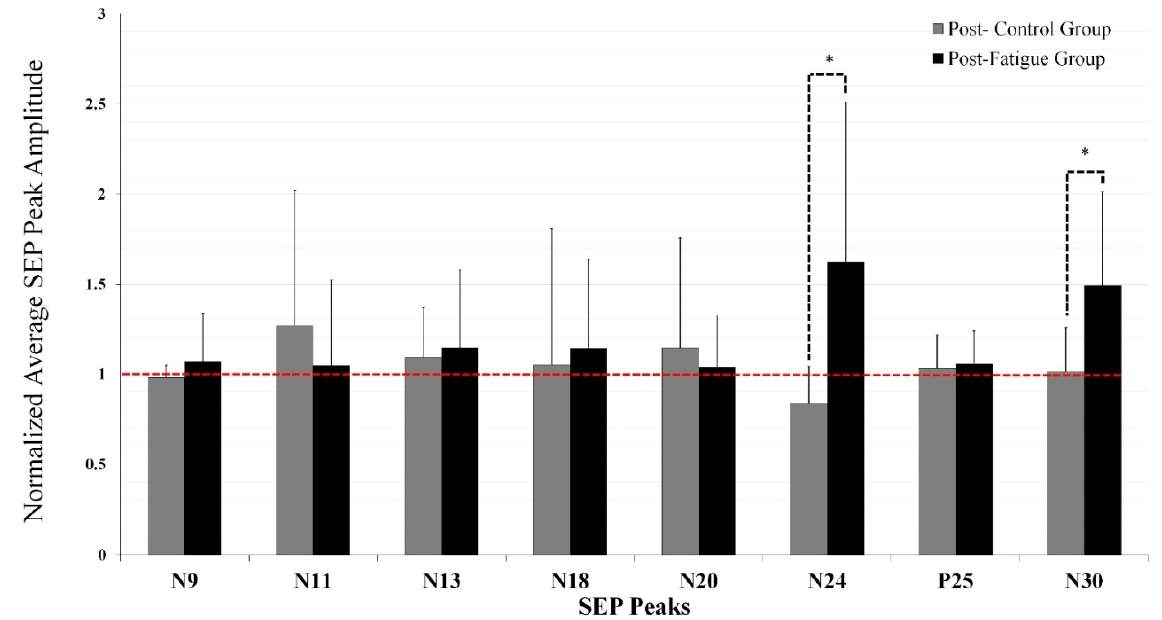
Figure 7. Averaged normalized SEP Peak amplitude ratios relative to baseline (dotted line) showing control vs. fatigue groups following motor skill acquisition tracing task. Note: significant interactive effects between groups were found for N24 and N30 SEP peaks (* p < 0.05). Following motor skill acquisition tracing task, significant changes from baseline were observed for both the control and fatigue group on N24 SEP peak and for fatigue group on N30 SEP peak. Error bars represent